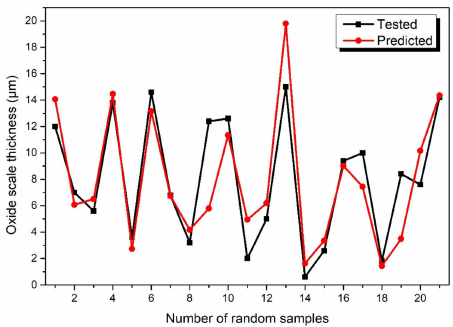
Figure 8. The testing data and the prediction results of the oxide scale thickness of back-propagation (BP) training